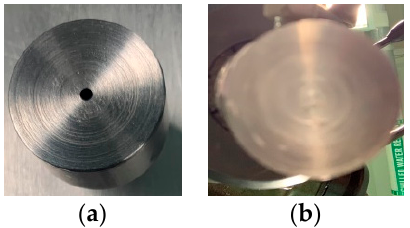
Figure 4. Photographs of ( a ) the tool before processing, and ( b ) blockage of 2 mm hole after processing using 2 mm hole size.